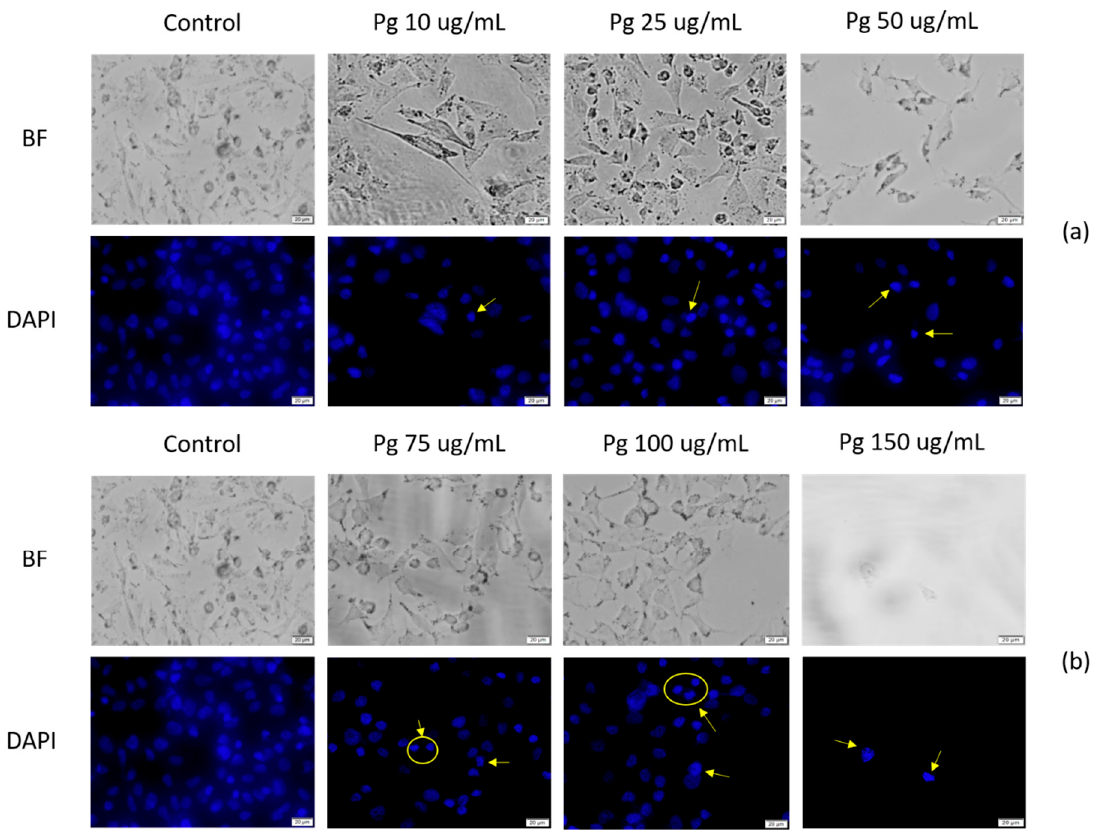
Figure 7. A549 human lung adenocarcinoma cells treated with Pg extract at different concentrations ( a ) (10, 25 and 50) and ( b ) (75, 100, and 150 µg/mL), for 72 h-DAPI staining was performed for apoptotic morphological characteristics; BF = bright field microscopy. The scale bars represent 20 µm. Pharmaceutics 2021 , 13 , x